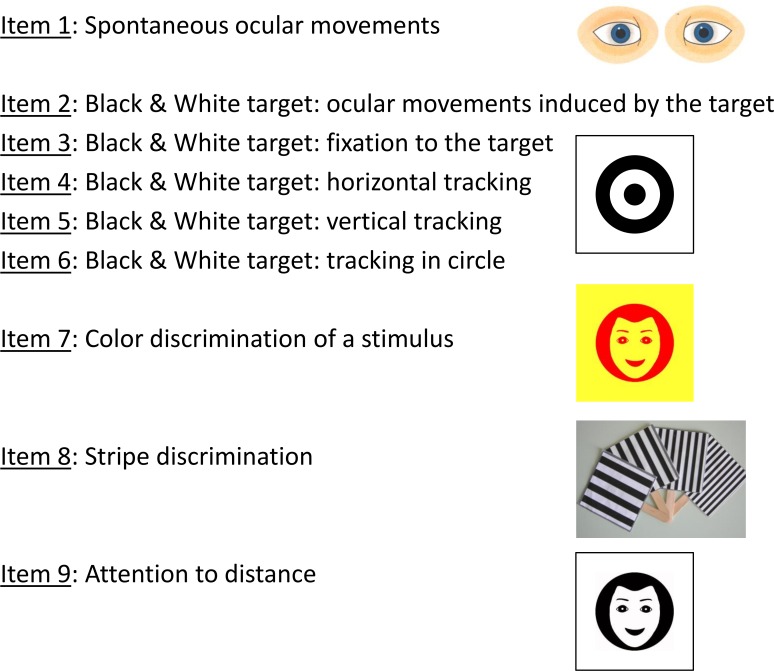
The nine items included in the visual assessment battery.Four different stimuli were used: a black and white target; a yellow and red colored face; a black and white target and 8 cards with stripes of different spatial frequency. Ocular movements were observed when the newborn was resting and while tracking with the black and white target. (Credit to D. Ricci)